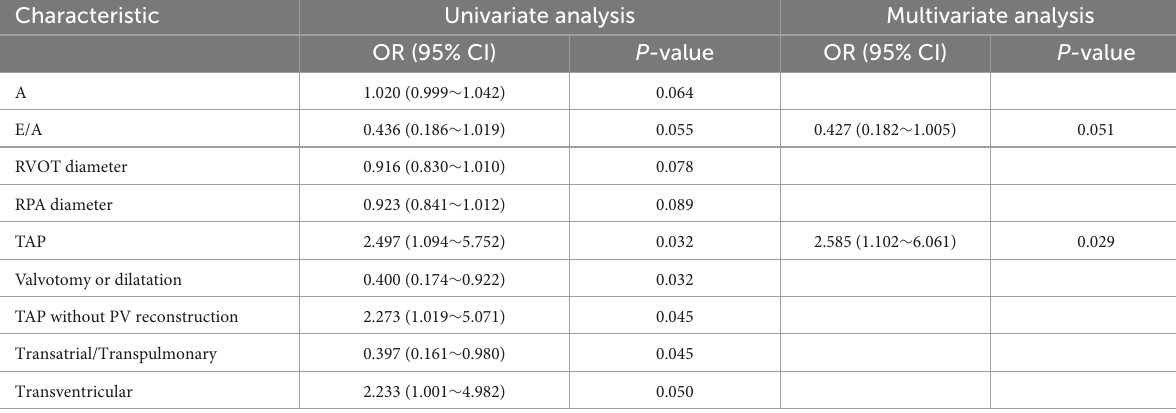
TABLE 2 Multivariate predictors of end-diastolic forward flow